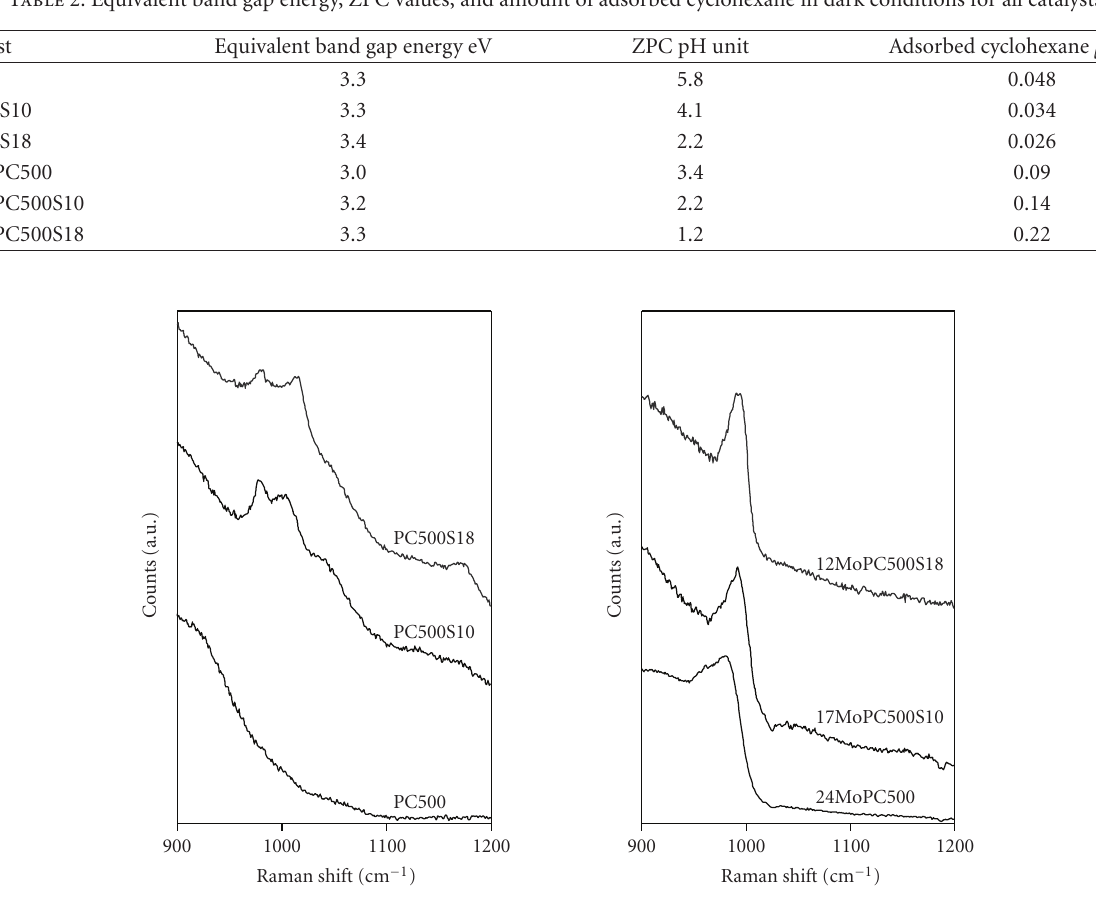
Figure 4: Raman spectra of PC500, PC500S10, PC500S18 (a) and of 24MoPC500, 17MoPC500S10, 12MoPC500S18 (b)